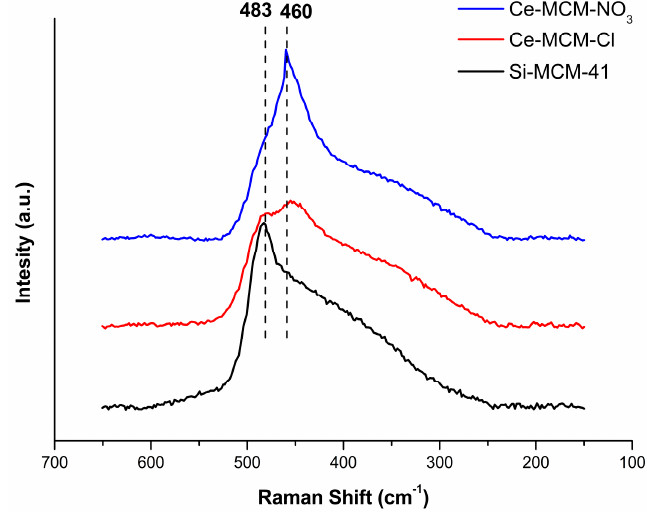
Figure 4. Raman spectra of the calcined materials between 150 and 650 cm − 1 .